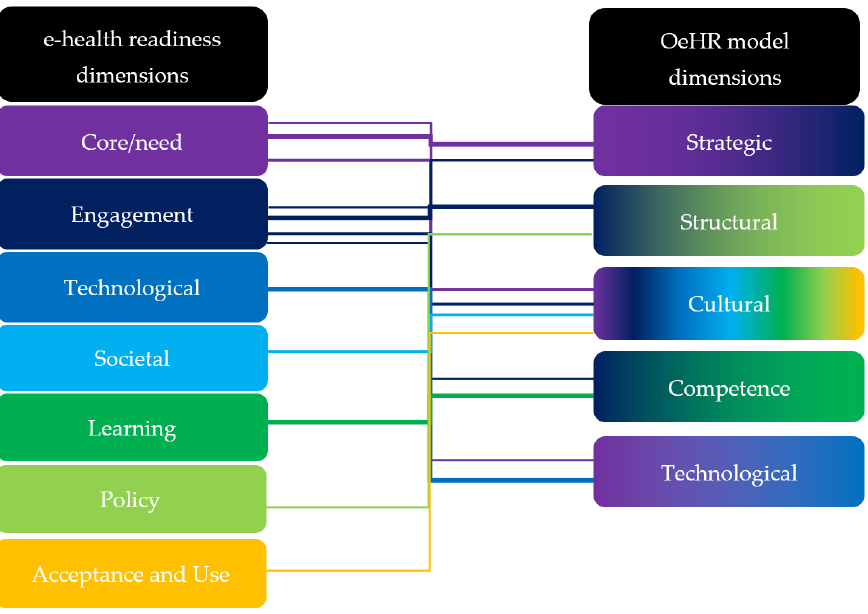
Figure 1. Conceptual process of developing the dimensions of the OeHR research model.